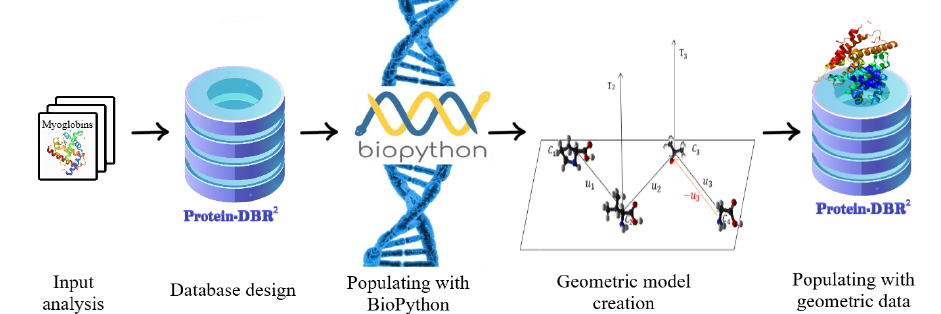
Figure 2. Process to realize the database management